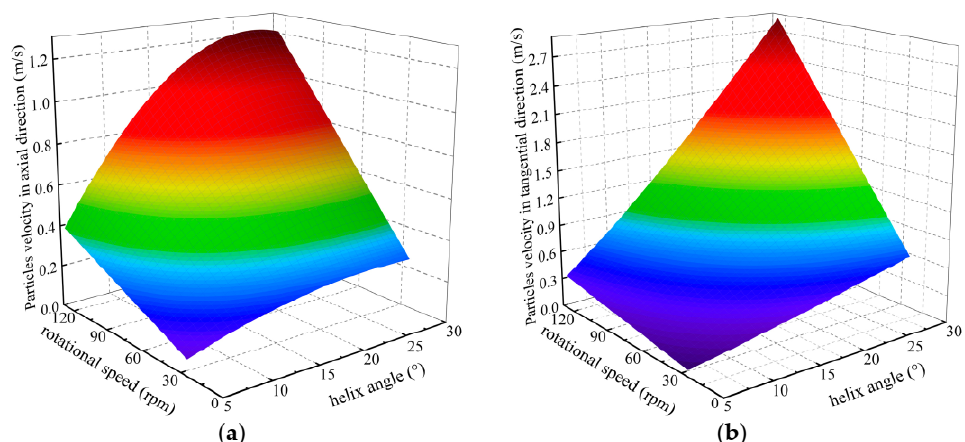
Figure 3. The theory velocity of particle: ( a ) axial velocity V a ; ( b ) tangential velocity V t